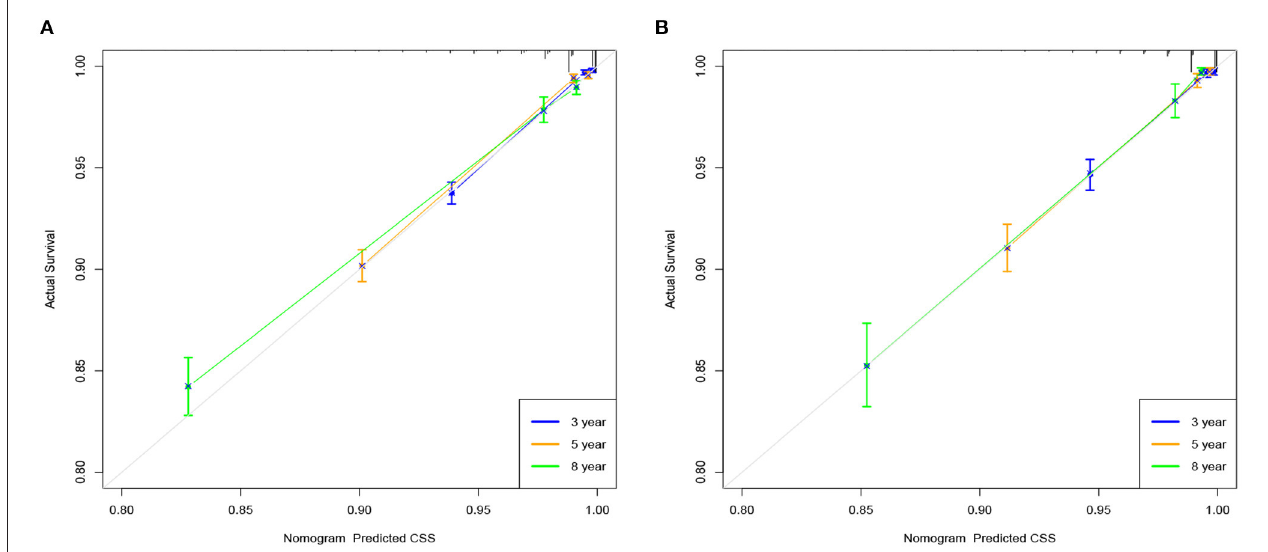
FIGURE 3 | Calibration curve of the nomogram in the training set (A) and validation set (B) . The horizontal axis is the predicted value in the nomogram, and the vertical axis is the observed value.